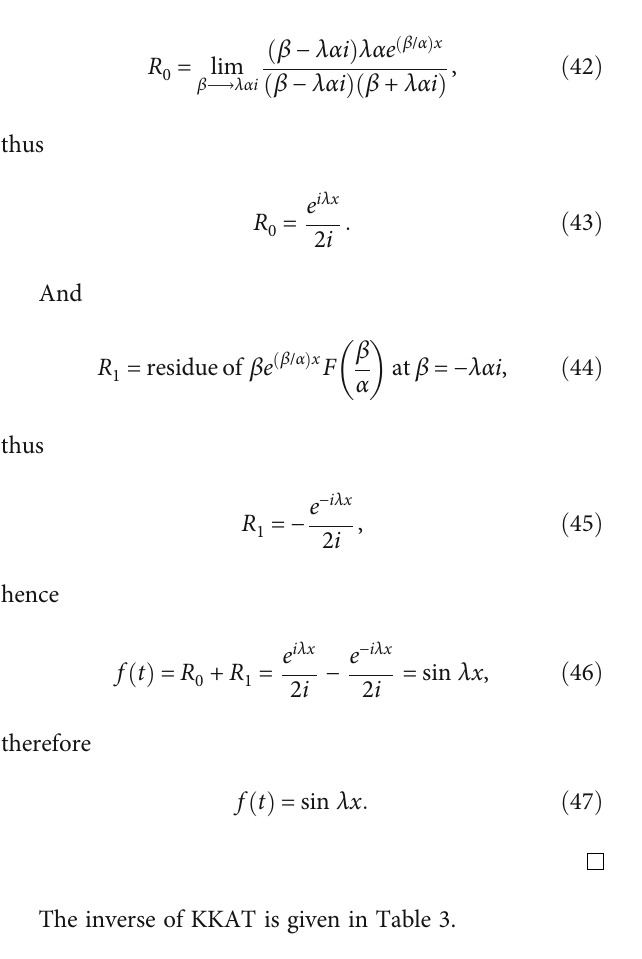
Table 3: Inverse